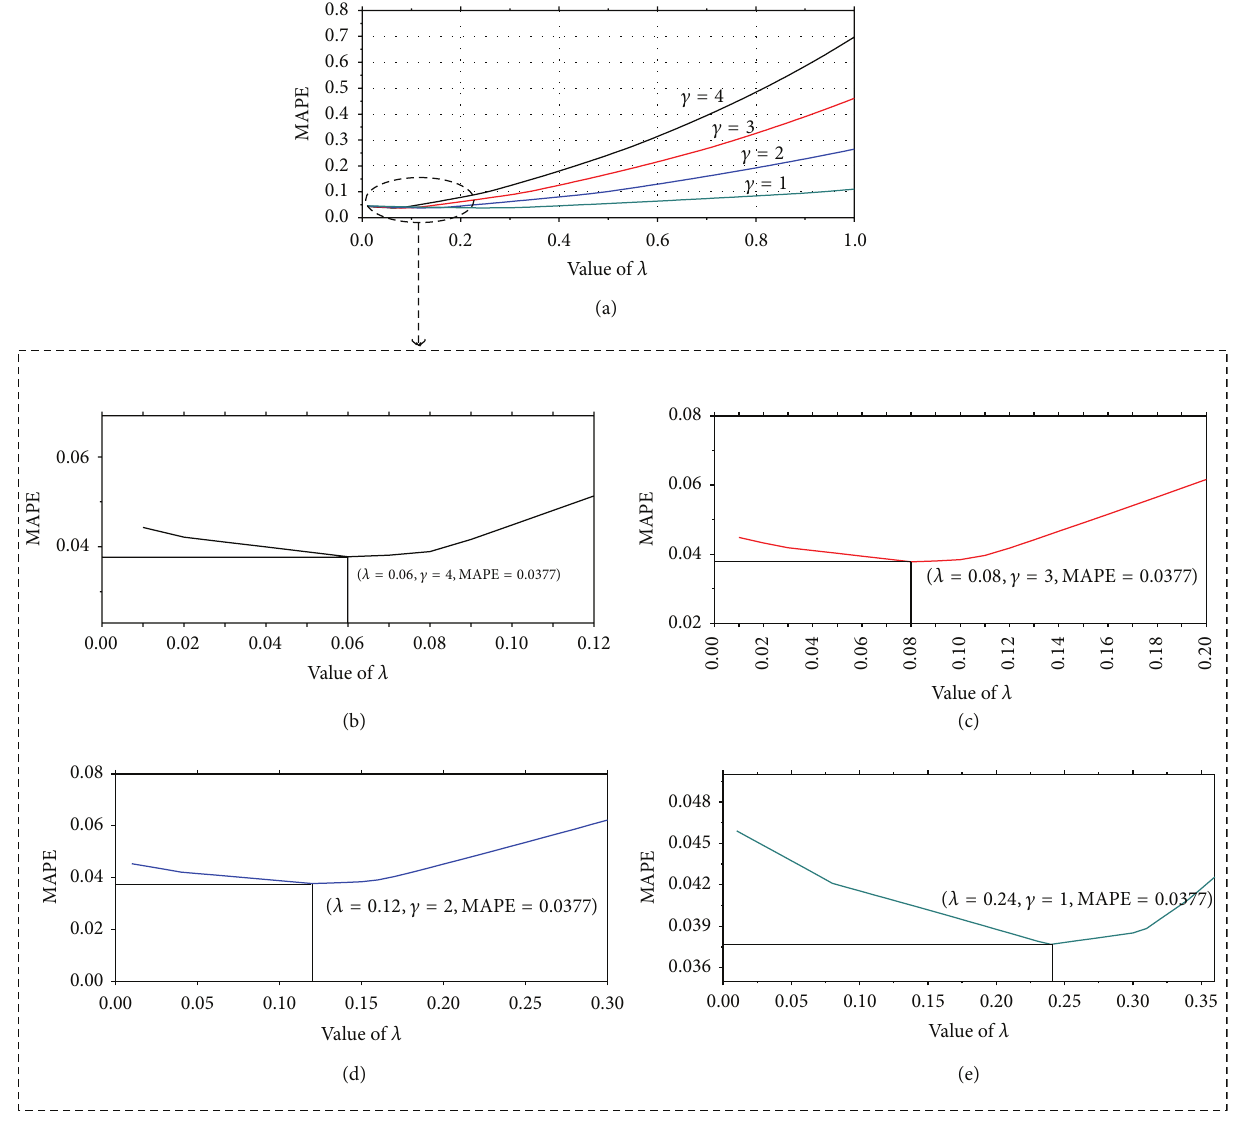
Figure 2: The trend of the function strength of the VWSBO with different indexes: (a) different indexes; (b) 𝛾 = 4 , 𝜆 = 0.06 ; (c) 𝛾 = 3 , 𝜆 = 0.08 ; (d) 𝛾 = 2 , 𝜆 = 0.12 ; (e) 𝛾 = 1 , 𝜆 = 0.24